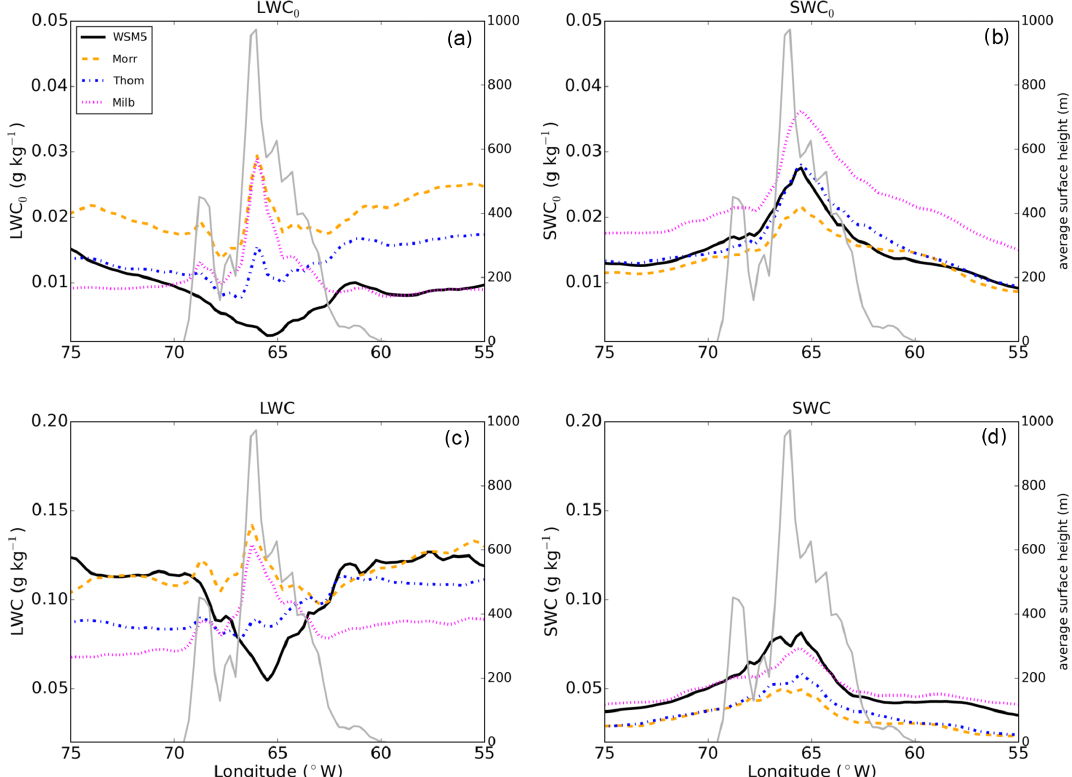
Figure 4. Longitudinal distribution of latitudinally (65.5–68.5 ◦ S) averaged LWC and SWC (gkg − 1 ) over both periods of interest for the WSM5, Morrison, Thompson, and Milbrandt schemes. The average is computed over all grid boxes and times, leading to (a) LWC 0 and (b) SWC 0 , or only over grid boxes and times where values are non-null, leading to LWC (c) and SWC (d) . The thick grey line shows the surface height averaged over the same region and labelled on the right vertical axis of each plot. Note the identical scales used for the vertical axes for LWC 0 and SWC 0 and for LWC and